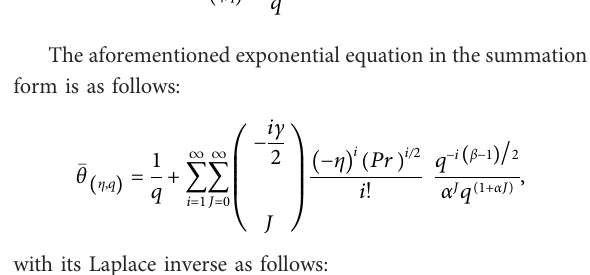
FIGURE 2 Temperature plot for β when α (cid:3) γ (cid:3) 0 . 8 , Pr (cid:3) 11 . 4 , and t (cid:3) 1 . 0.